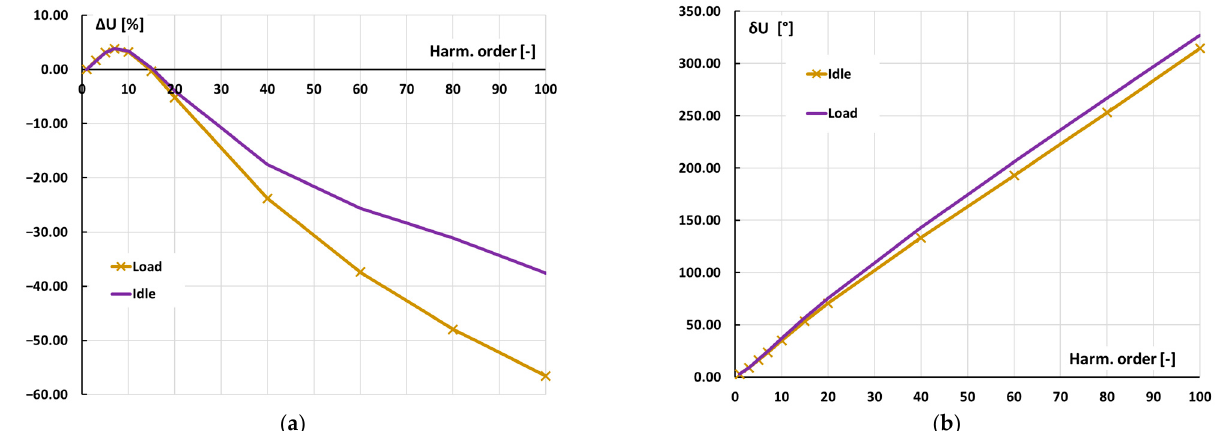
Figure 14. Voltage gain errors ( a ) and phase shift ( b ) with the frequency of the input voltage.